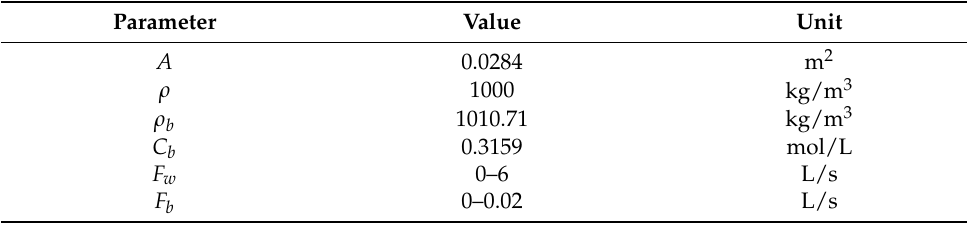
Table 1. The parameters and constraints of the studied pH process.